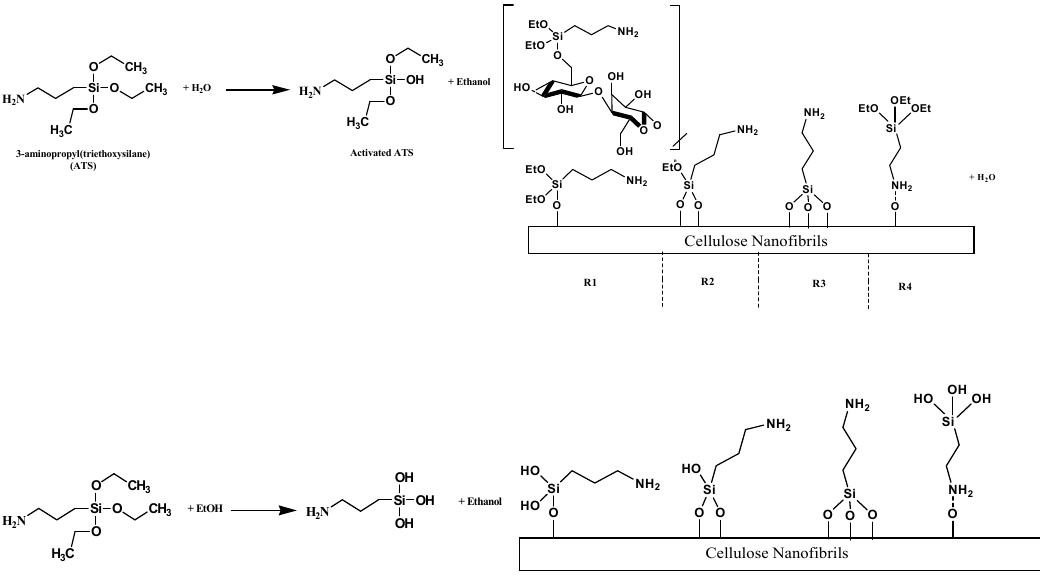
Figure 7. Schematic illustration of the reactions / interactions between aminopropyl triethoxysilane (ATS) and cellulose nanofibrils. Adapted from [49].